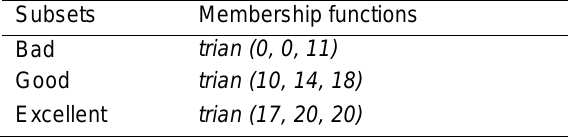
Table 1. Membership functions of the output variable